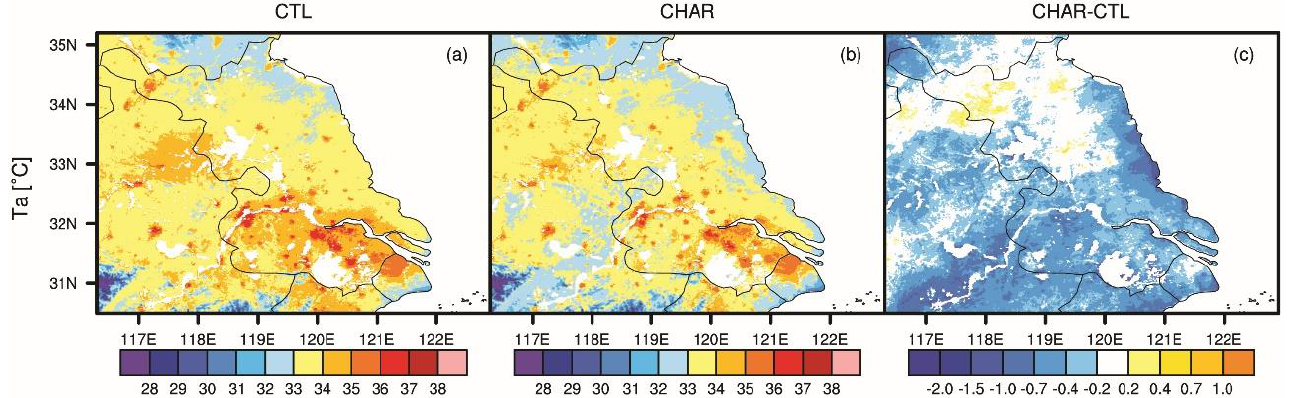
Figure 6. Spatial distribution of mean air temperature (unit: ◦ C) for ( a ) CTL experiment, ( b ) CHAR experiment, and ( c ) their difference over the research period in